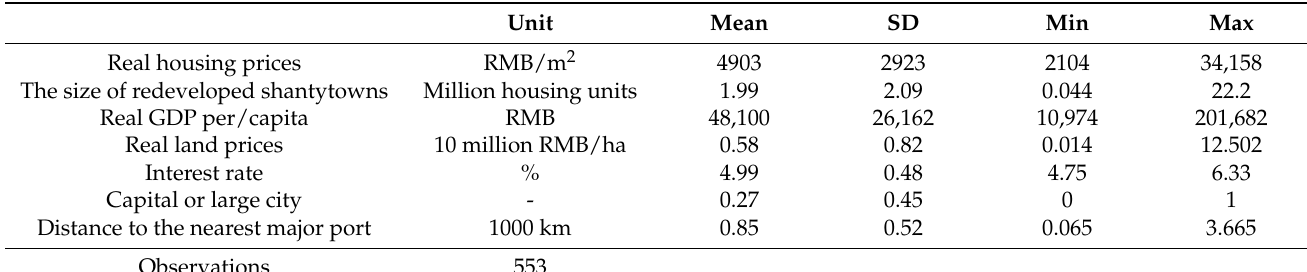
Table 2. Descriptive